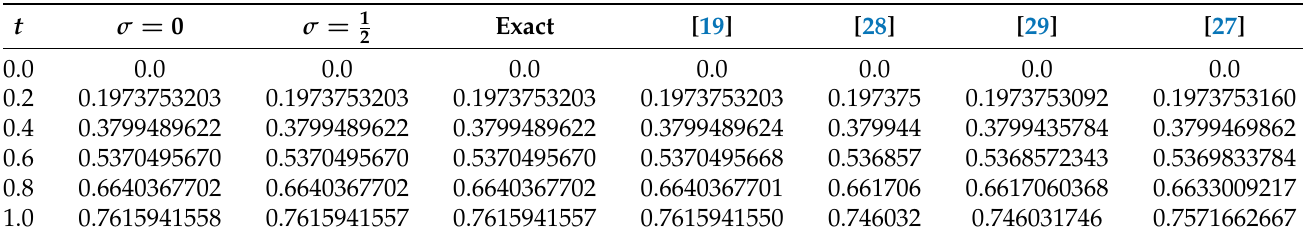
Table 2. Comparison between our method [19,27–29], methods for φ ( t ) of Example 1, with n = 15, α = β = ρ = 1.